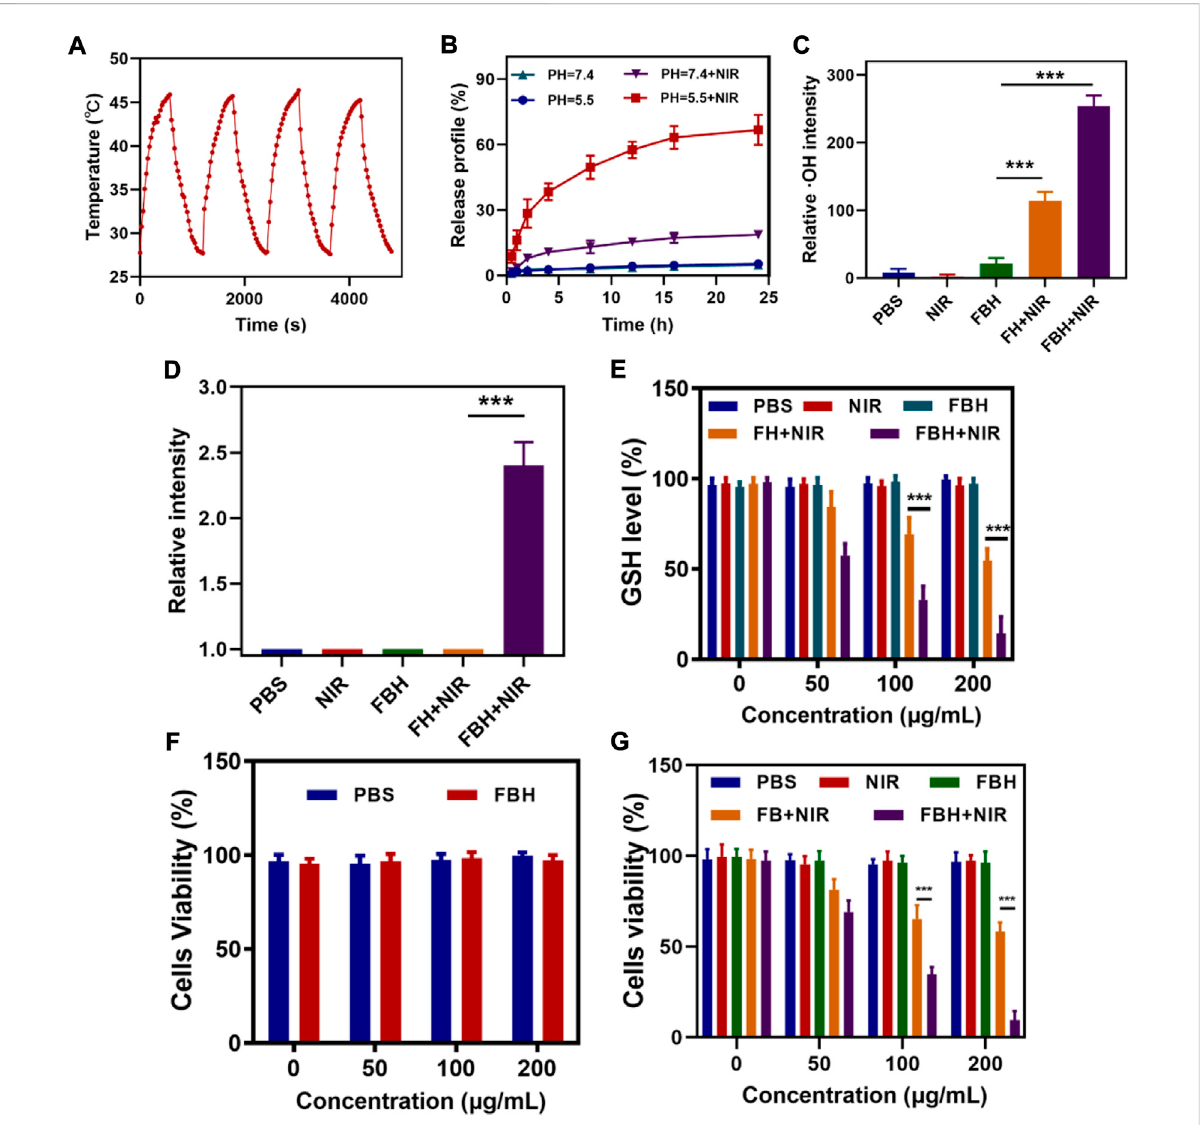
FIGURE 2 (A) Heating curve of FBH under four cycles of heating and cooling processes. (B) The release curve of SO 2 from FBH after different treatments. (C) Relative OH intensity in cells after treated by different experimental groups (n = 3). (D) Relative SO 2 intensity in cells after treated by different experimentalgroups(n=3). (E) TheeffectofdifferentformulationsontheintracellularGSHlevelswasdetermined byemployingaGSHassay kit(n= 3). (F) Cell viabilities of control group (PBS) and FBH system without NIR irradiation (n = 3). (G) Various treatments ’ in vitro cytotoxicity towards 4T1 cells (n = 3). * p < 0.05, ** p < 0.01, *** p < 0.005; Student ’ s